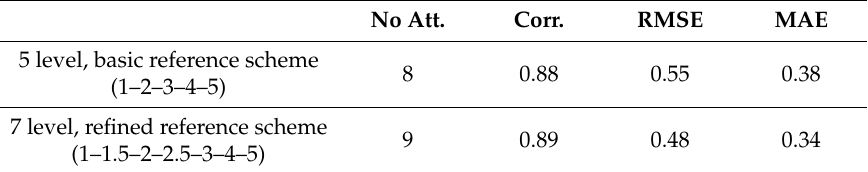
Table 5. Performance of an RF regression for the basic five-level reference scheme and the refined reference scheme with seven stress levels based on WV2 attributes for crowns with a diameter larger than 4 m. The correlation (corr.), root mean squared error (RMSE), and mean absolute error (MAE) were calculated for an RF regression (depth 8, 200 iterations) in a three-fold random split with 1000 repetitions. No Att. Corr.